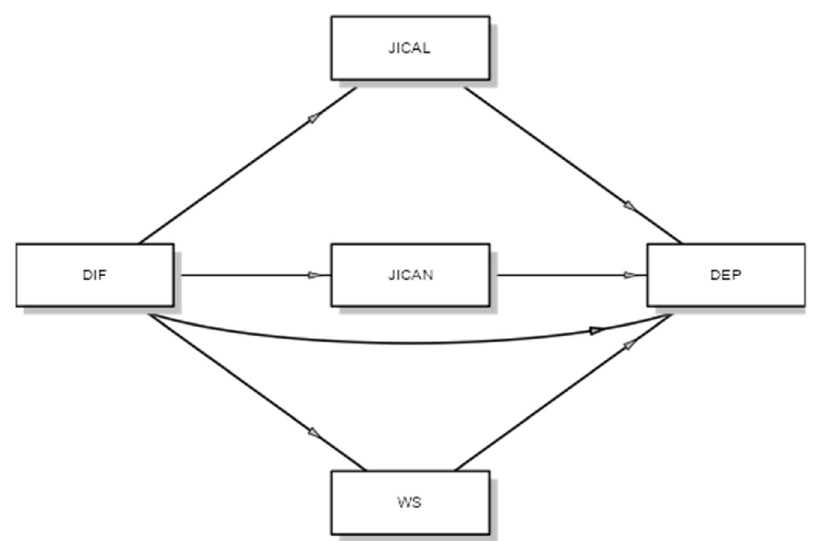
Figure 1. Model diagram for qualitative and quantitative job insecurity, and work meaning as mediators in the relationship between material difficulties and depression.